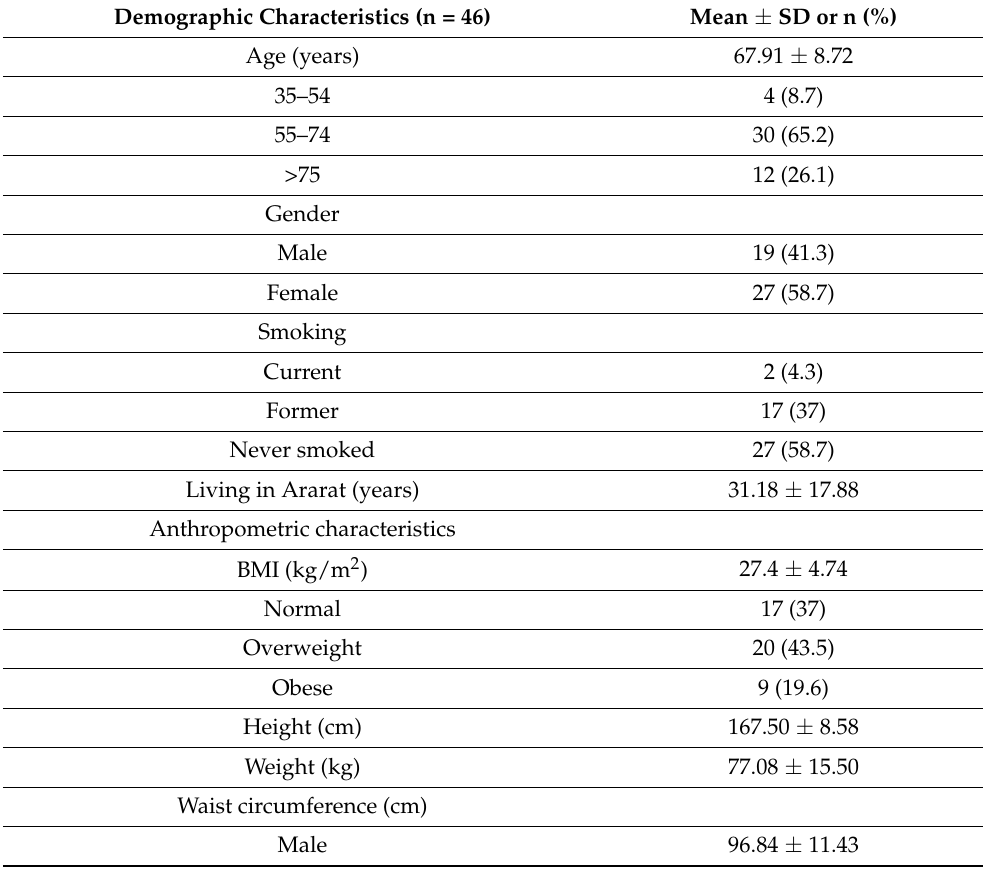
Table 1. Demographic characteristics of the study